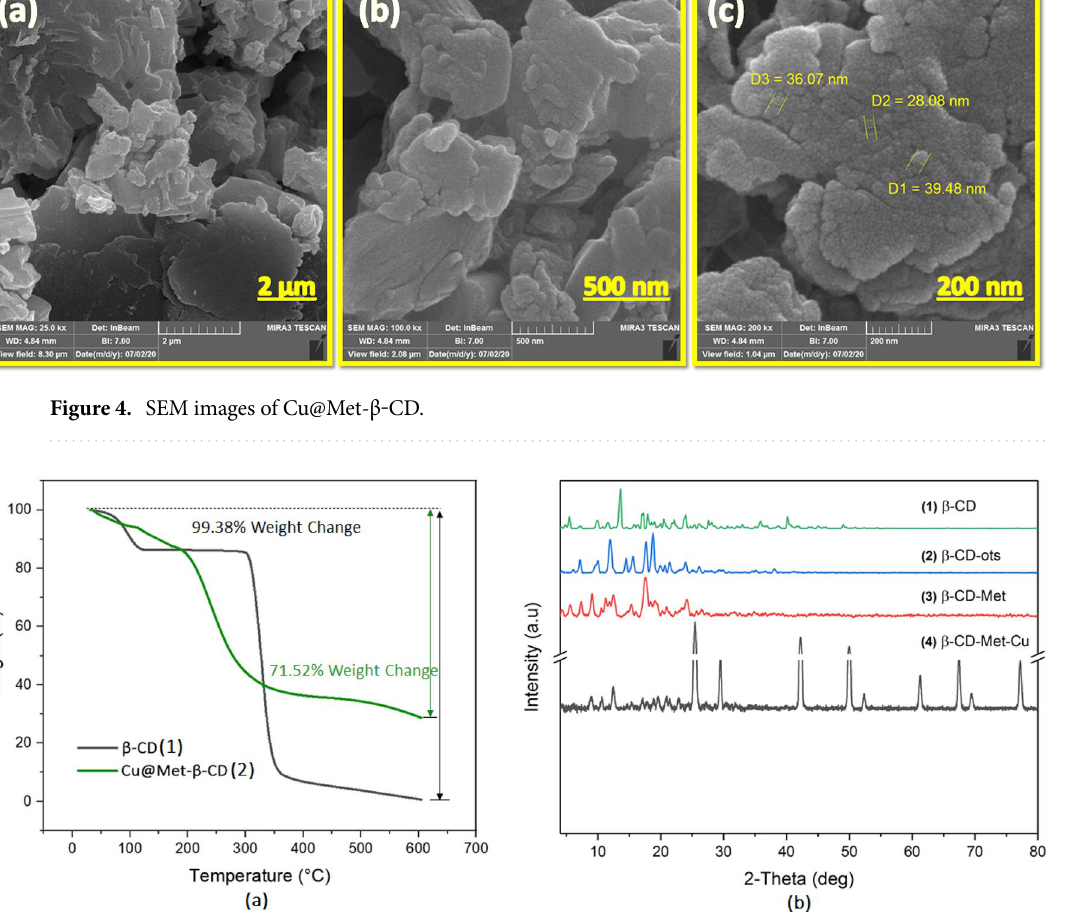
Figure 5. ( a ): TGA curves recorded in the air at a heating rate of 10 °C min −1 , ( b ): XRD